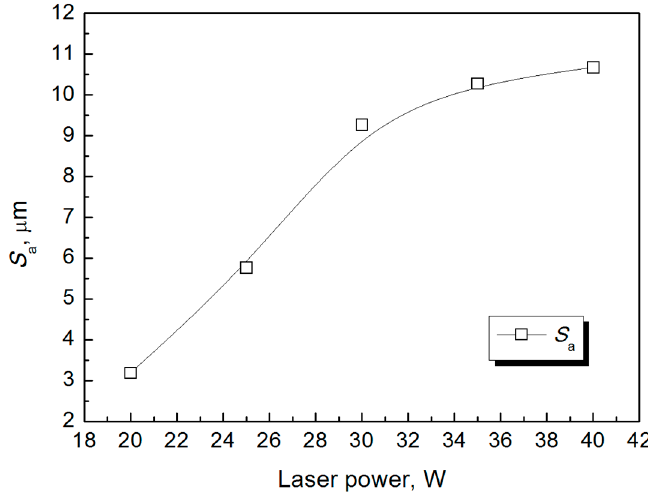
Figure 4. Surface roughness after laser milling at different laser powers.